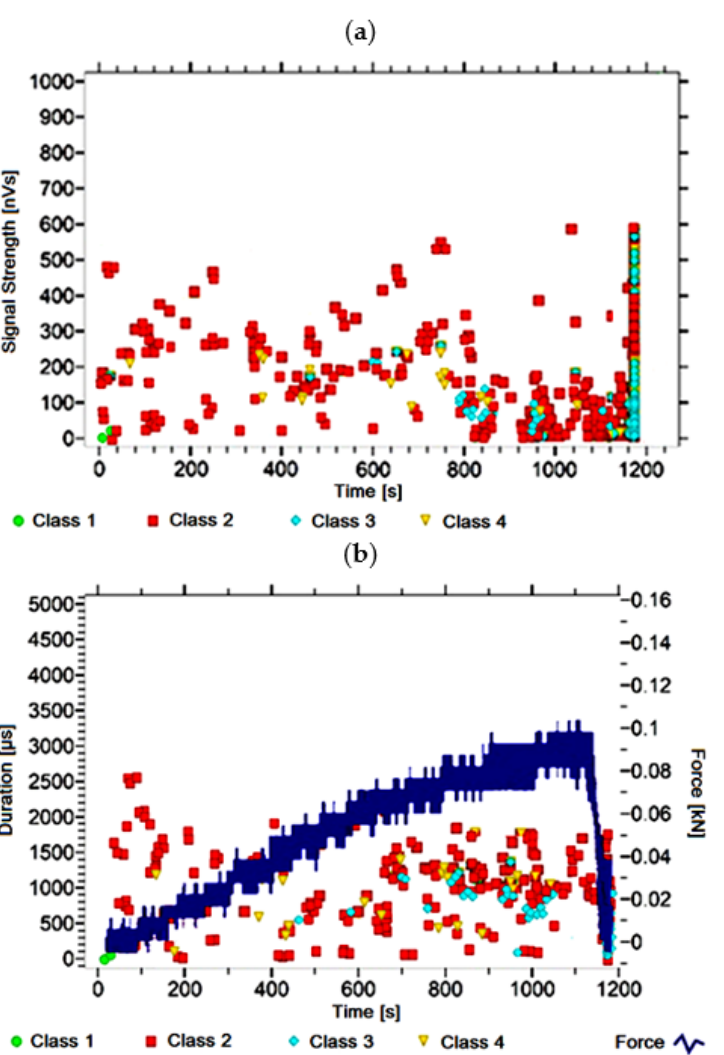
Figure 12. Graphs of acoustic emission signals for an exemplary sample of A 11 series: ( a ) signal strength over time; ( b ) distribution of the duration of the signals over time with the force increment curve.